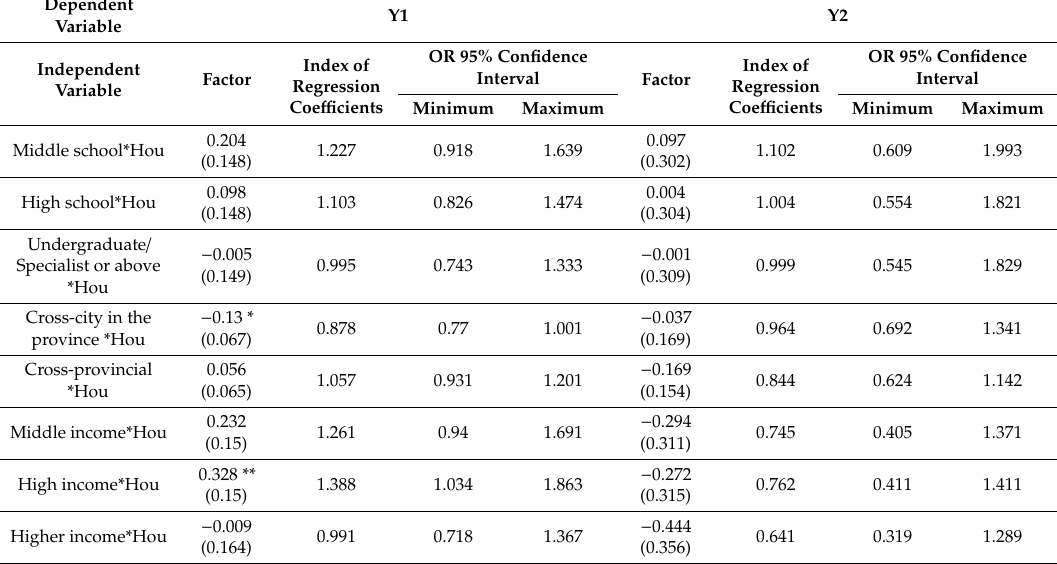
Table 3. Binary logistic regression results for